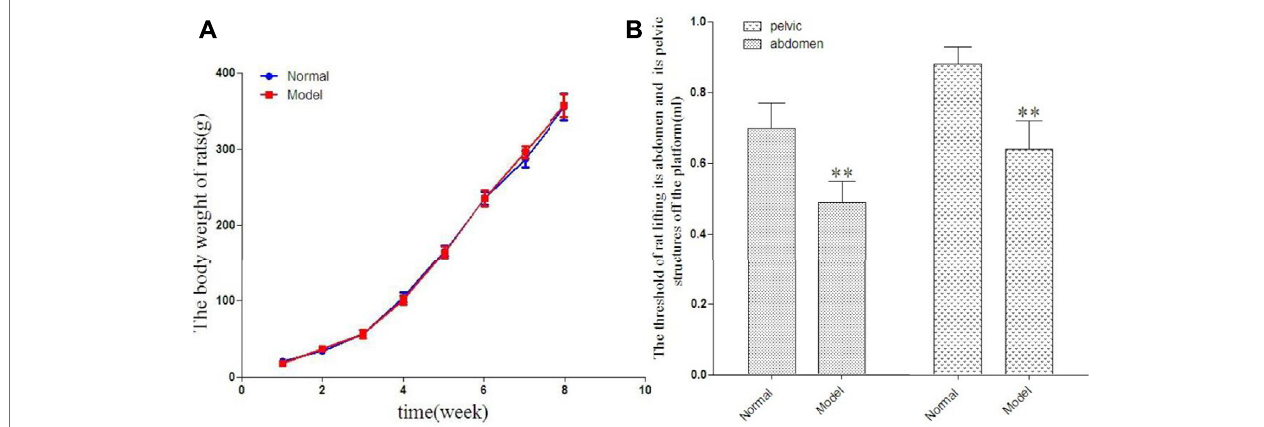
FIGURE 1 | The change of rat in body weightin 8 weeks [ (A) , g] and the threshold ofrat lifting its abdomen off the platform and its pelvic structures off the platform [ (B) ,